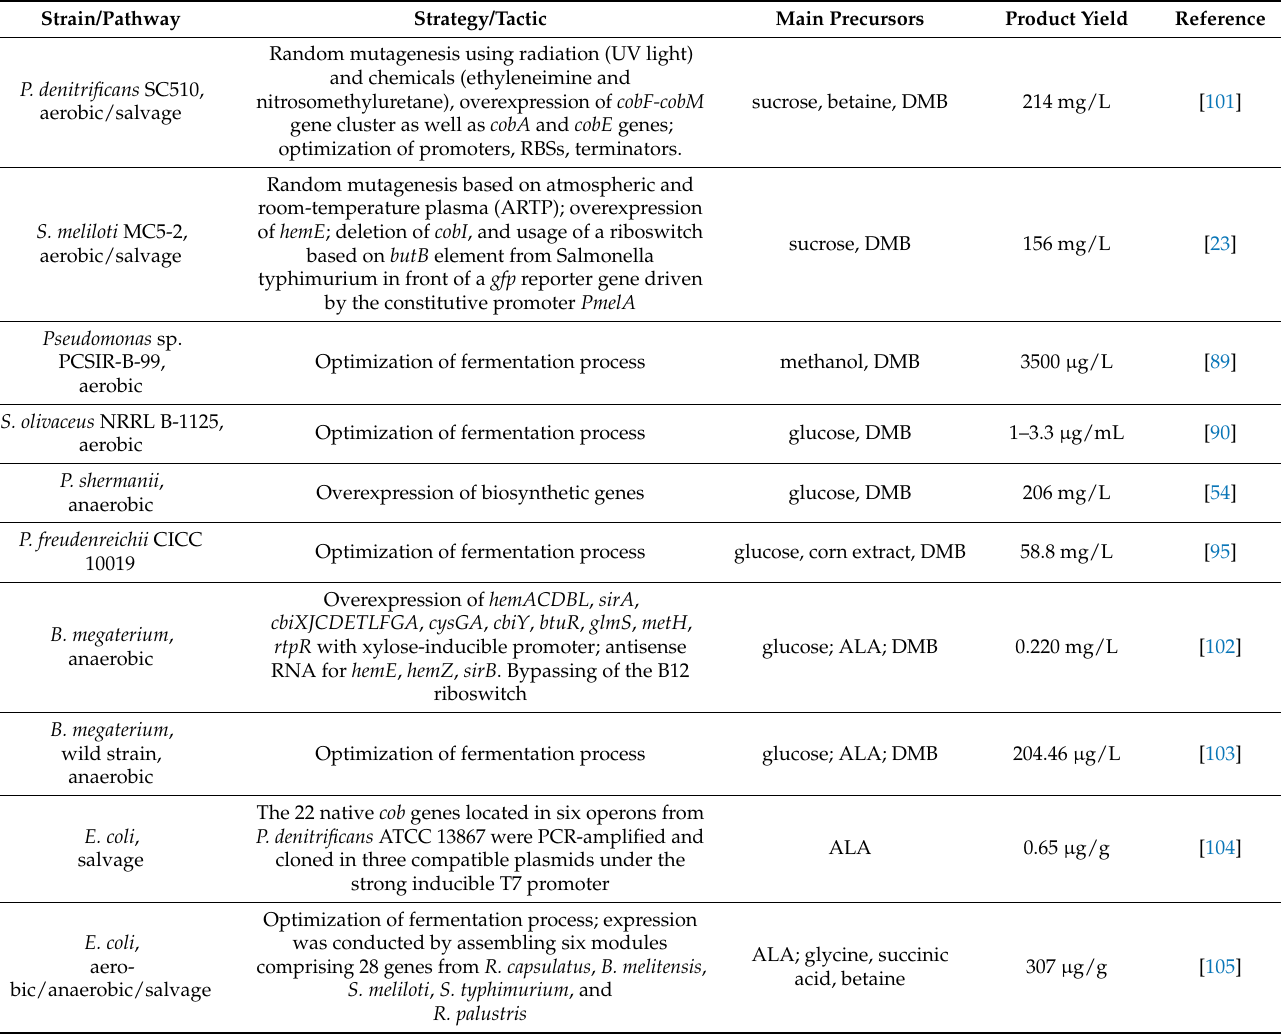
Table 2. Selected strains for vitamin B12 fermentation